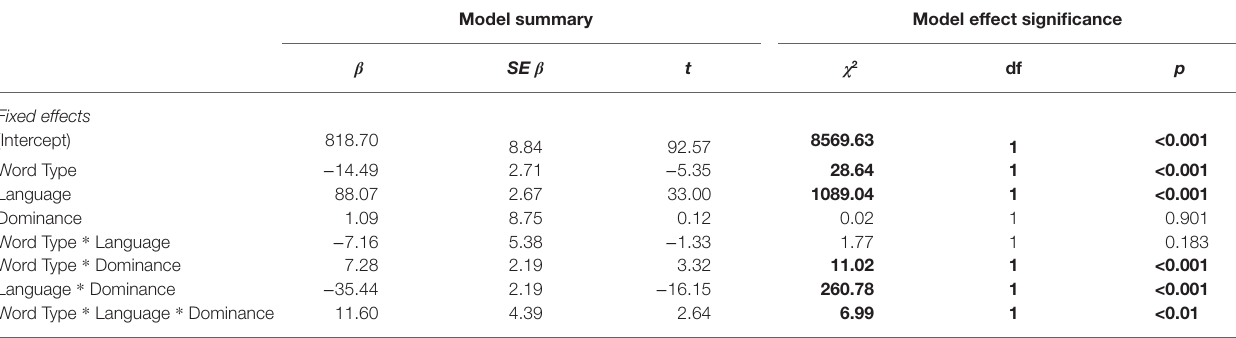
TABLE 4 | Results of linear mixed effects regression model on response times in the lexical decision